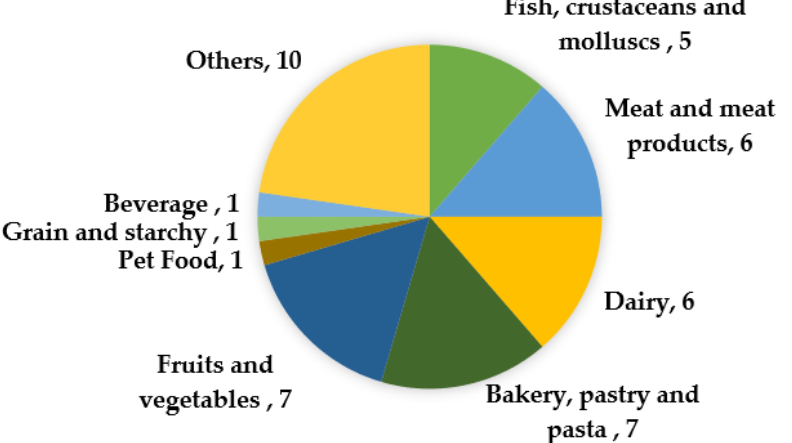
Figure 1. Number of surveyed agri-food industry respondents considered in the study by sector of activity.